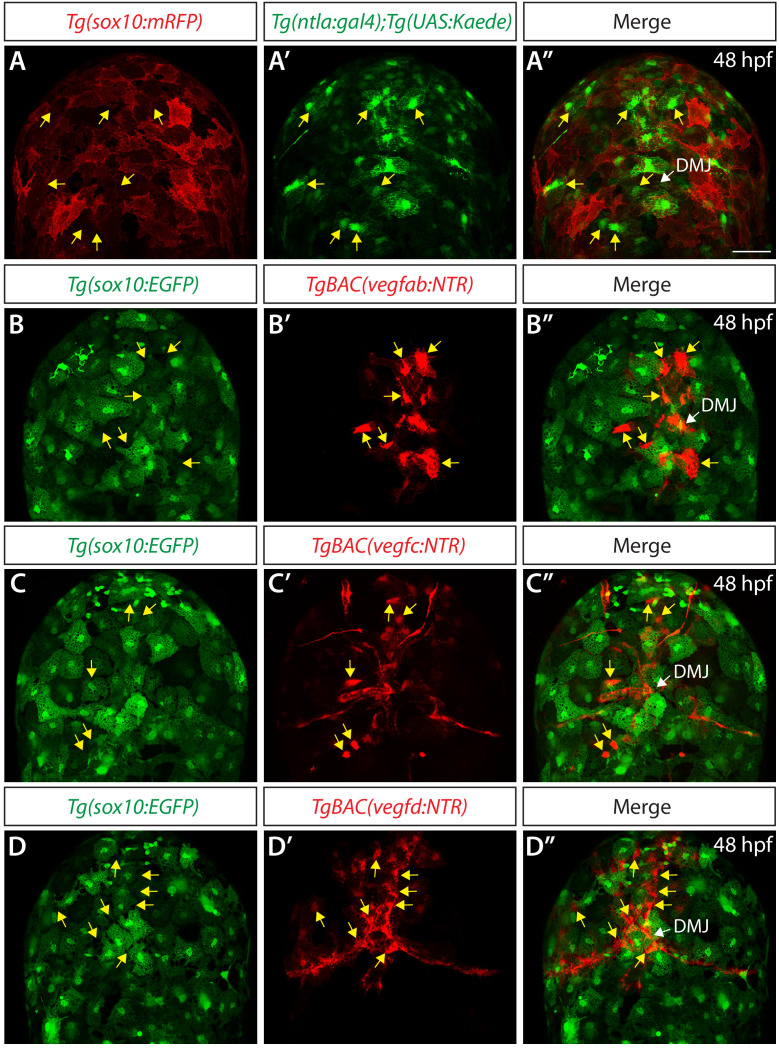
Co-localization analyses in TgBAC(vegfab:NTR), TgBAC(vegfc:NTR), and TgBAC(vegfd:NTR) embryos that carried the Tg(sox10:EGFP) transgene.(A–A") Confocal maximum projection images of the dorsal views of a 48 hpf Tg(ntla:gal4);Tg(UAS:Kaede);Tg(sox10:mRFP) embryo, showing intermingled distribution of Kaede+ and mRFP+ meningeal cells (n = 7 embryos; 180 Tg(ntla:gal4);Tg(UAS:Kaede)+ cells examined; 1 cell co-localized with Tg(sox10:mRFP)+ cell). Yellow arrows point to some of the Kaede+ meningeal cells that were clearly not mRFP+ even on the maximum projection images. (B–B") Confocal maximum projection images of the dorsal views of a 48 hpf Tg(sox10:EGFP);TgBAC(vegfab:NTR) embryo, showing non-overlapping distribution of EGFP+ and NTR-mCherry+ meningeal cells (n = 12 embryos; 80 TgBAC(vegfab:NTR)+ cells examined; 2 cells co-localized with Tg(sox10:EGFP)+ cells). Yellow arrows point to some of the NTR-mCherry+ meningeal cells that were clearly not EGFP+ even on the maximum projection images. (C–C") Confocal maximum projection images of the dorsal views of a 48 hpf Tg(sox10:EGFP);TgBAC(vegfc:NTR) embryo, showing non-overlapping distribution of EGFP+ and NTR-mCherry+ meningeal cells (n = 4 embryos; 66 TgBAC(vegfc:NTR)+ cells examined; 0 cells co-localized with Tg(sox10:EGFP)+ cells). Yellow arrows point to some of the NTR-mCherry+ meningeal cells that were clearly not EGFP+ even on the maximum projection images. (D–D") Confocal maximum projection images of the dorsal views of a 48 hpf Tg(sox10:EGFP);TgBAC(vegfd:NTR) embryo, showing non-overlapping distribution of EGFP+ and NTR-mCherry+ meningeal cells (n = 4 embryos; 66 TgBAC(vegfd:NTR)+ cells examined; 2 cells co-localized with Tg(sox10:EGFP)+ cells). Yellow arrows point to some of the NTR-mCherry+ meningeal cells that were clearly not EGFP+ even on the maximum projection images. Scale bar: 50 μm.